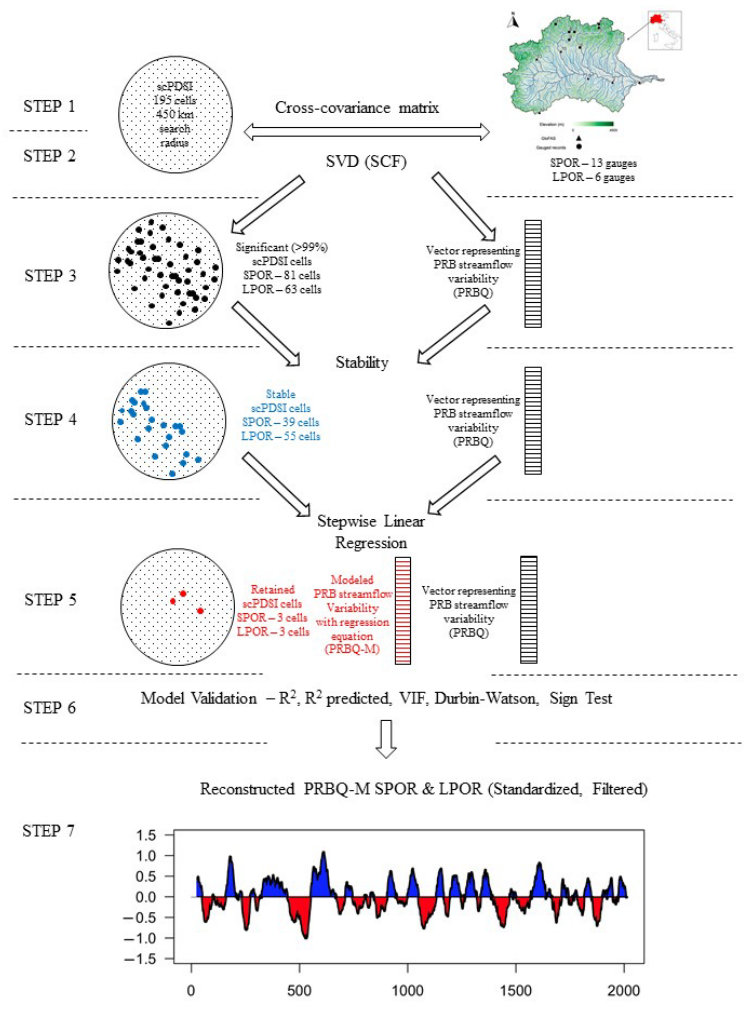
Figure 2. Flowchart displaying the steps to develop the Po River regional